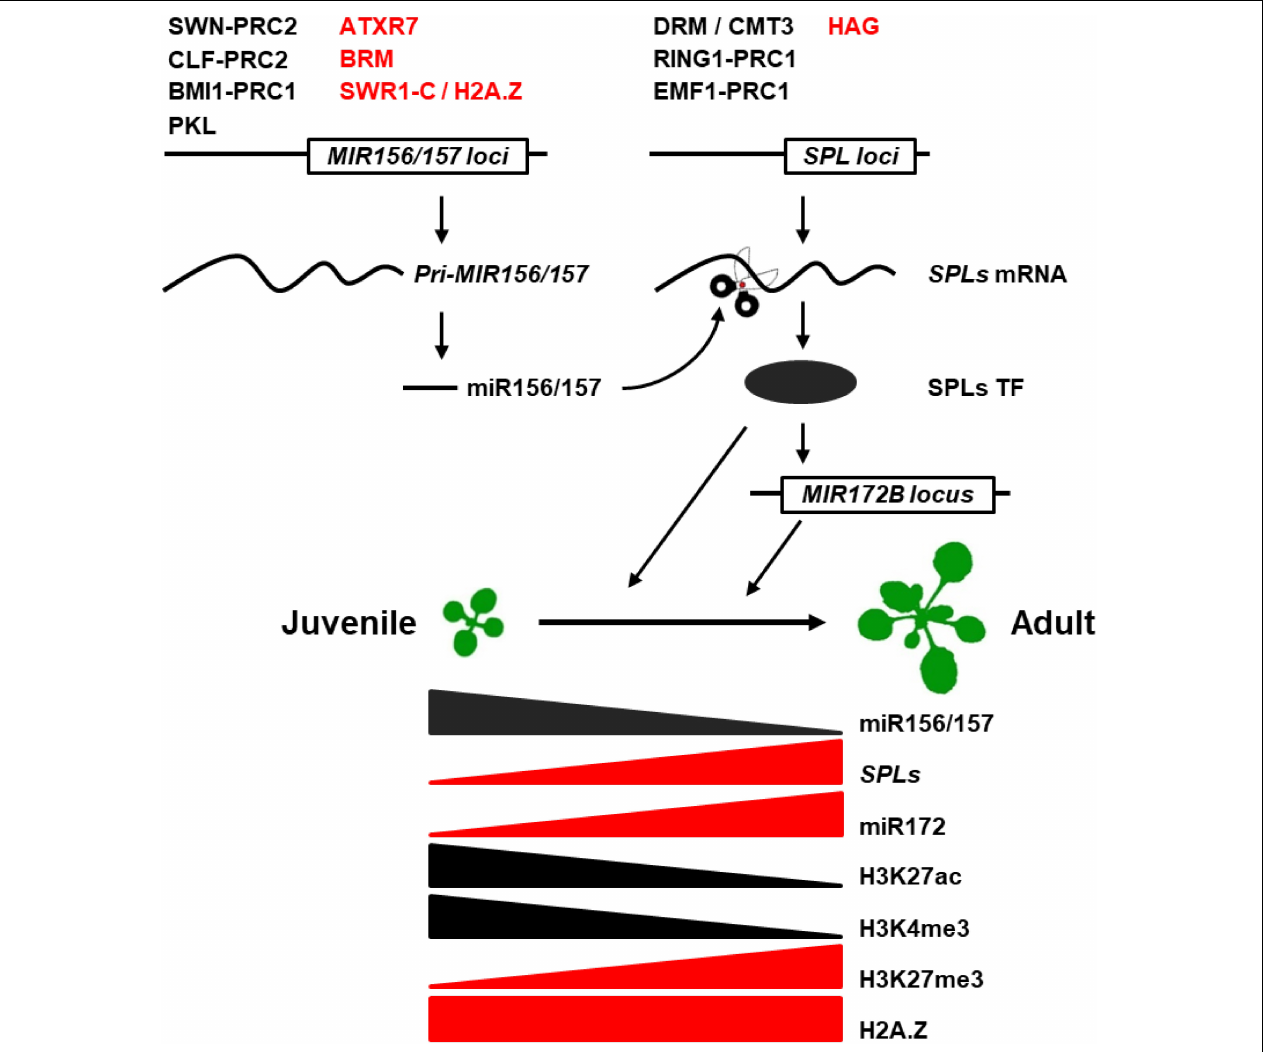
FIGURE 1 | Epigenetic regulation of juvenile-to-adult transition in plants. Active and repressive epigenetic regulators were marked in red and black at MIR156 / 157 and SPL loci, respectively. Triangle indicates gradual increase or decrease in the epigenetic modification levels of MIR156